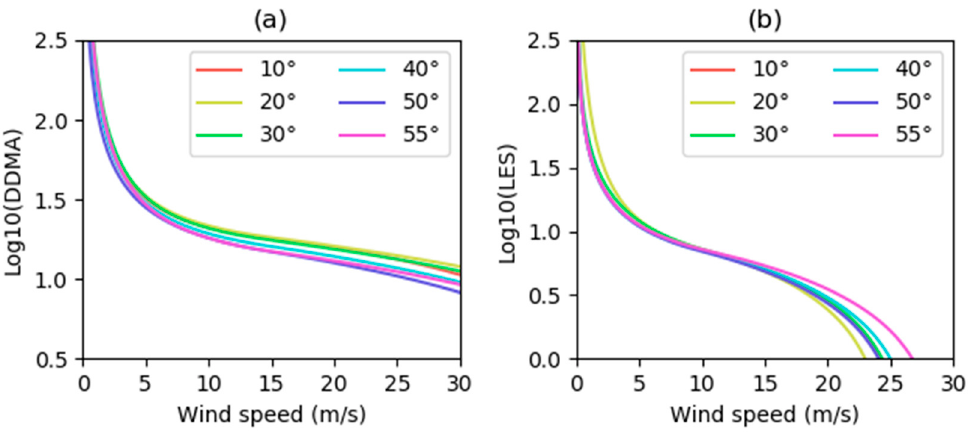
Figure 6. Delay-Doppler Map Average ( a ) and Leading Edge Slope ( b ) geophysical model function at specific incidence angles using Numerical Weather Prediction winds as the ground truth wind speed.